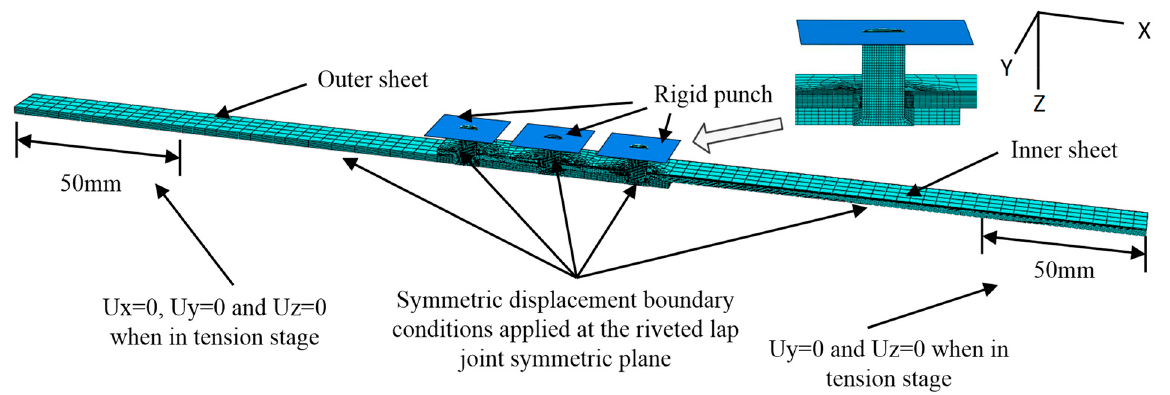
Figure 4. FE model of the riveted lap joint.